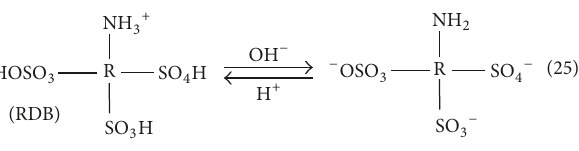
Scheme 2: Equilibrium of RDB in